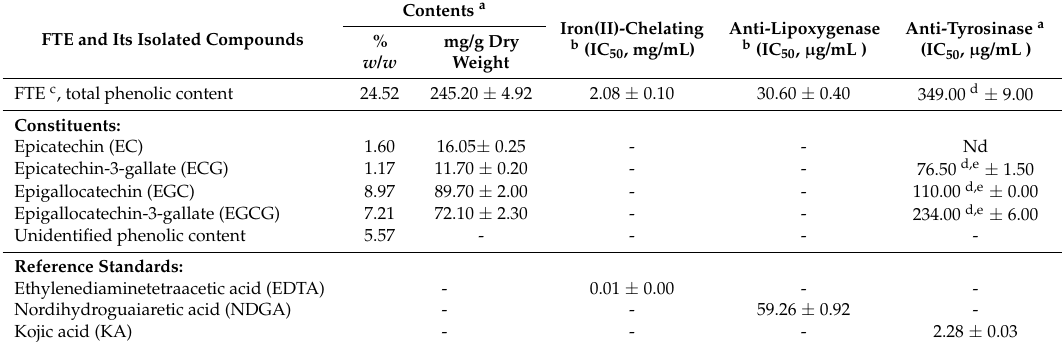
Figure 3. The metal chelating effect of the FTE and EDTA. Data are expressed as the mean ± SD ( n = 2). Table 2. The constituents and contents of the FTE and the concentration providing 50% inhibition of the iron(II) chelating capacity, lipoxygenase, and tyrosinase activities of the FTE and its four isolated pure compounds, including reference standards. The values represent the mean ± SD or the mean ± standard error of the mean (SEM).